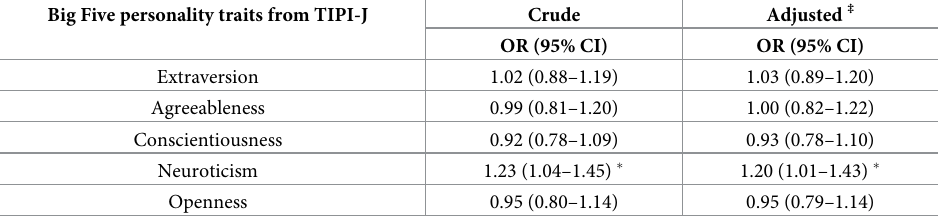
Table 6. Logistic regression results for association between Big Five personality traits and food stockpiling stage; “interrupted stockpiled” vs “continuous stockpiling” (n = 471) †